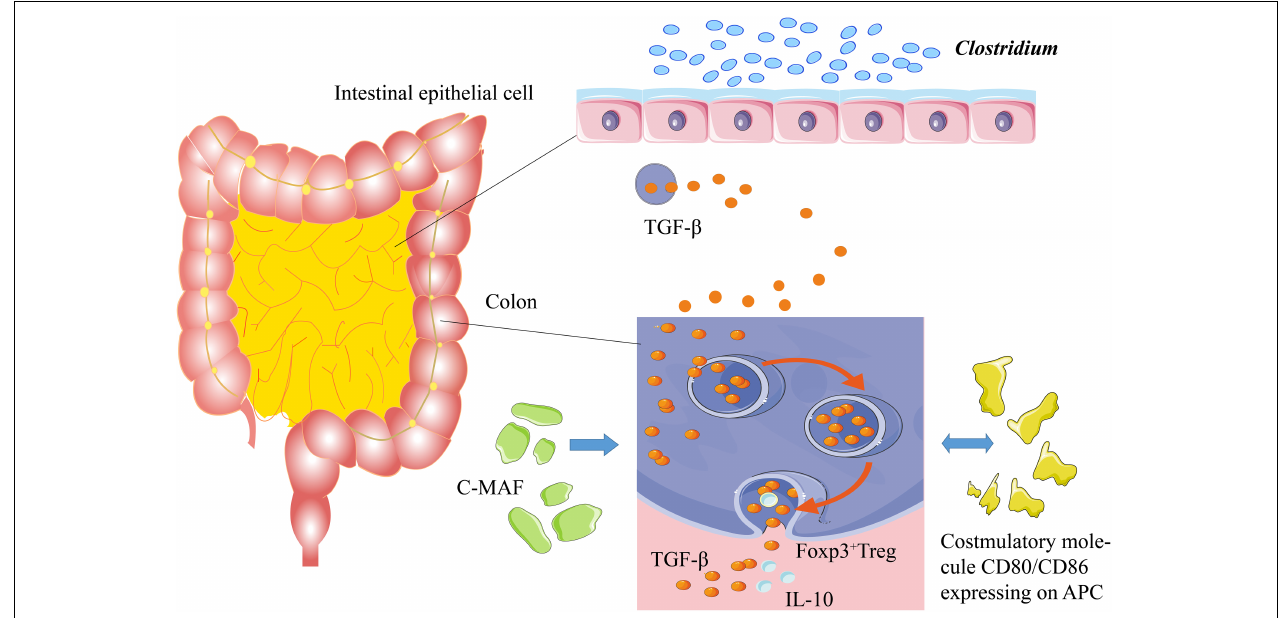
FIGURE 1 | Mechanism of immune tolerance. Some Clostridium species stimulate the intestines to secrete TGF- β . TGF- β can induce Foxp3 + Treg cells in the colon to secrete IL-10, thereby promoting immune tolerance. c-MAF, a T cell transcription factor, is the key factor to sustain the stability of gut microbiota. The costimulatory molecules of CD80/CD86, which are expressed on the antigen-presenting cells, stimulate the secretion of TGF- β and